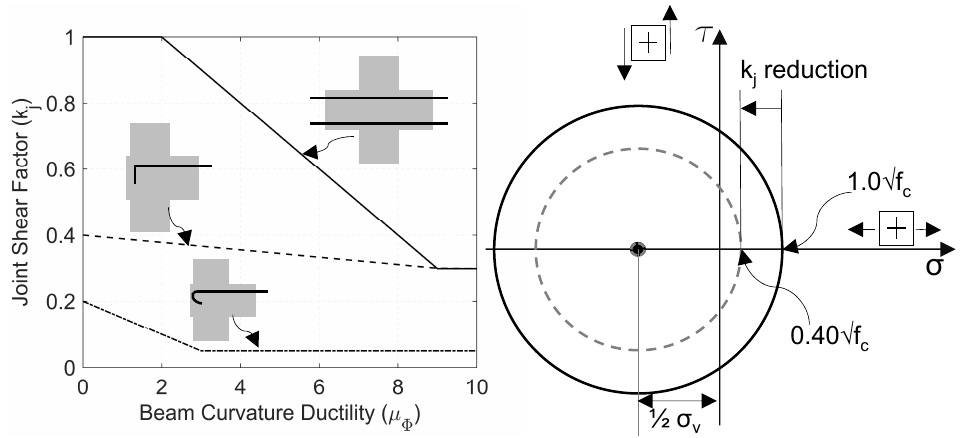
Figure 4. Definition of k j coefficient according to New Zealand code